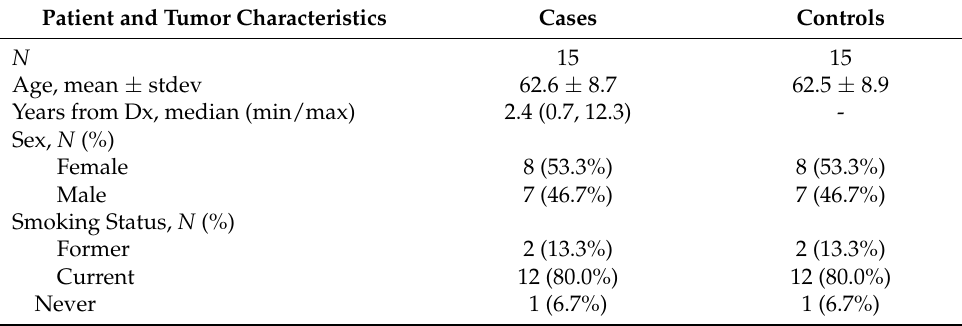
Table 2. Patient and tumor characteristics for the entire pre-diagnostic SCLC